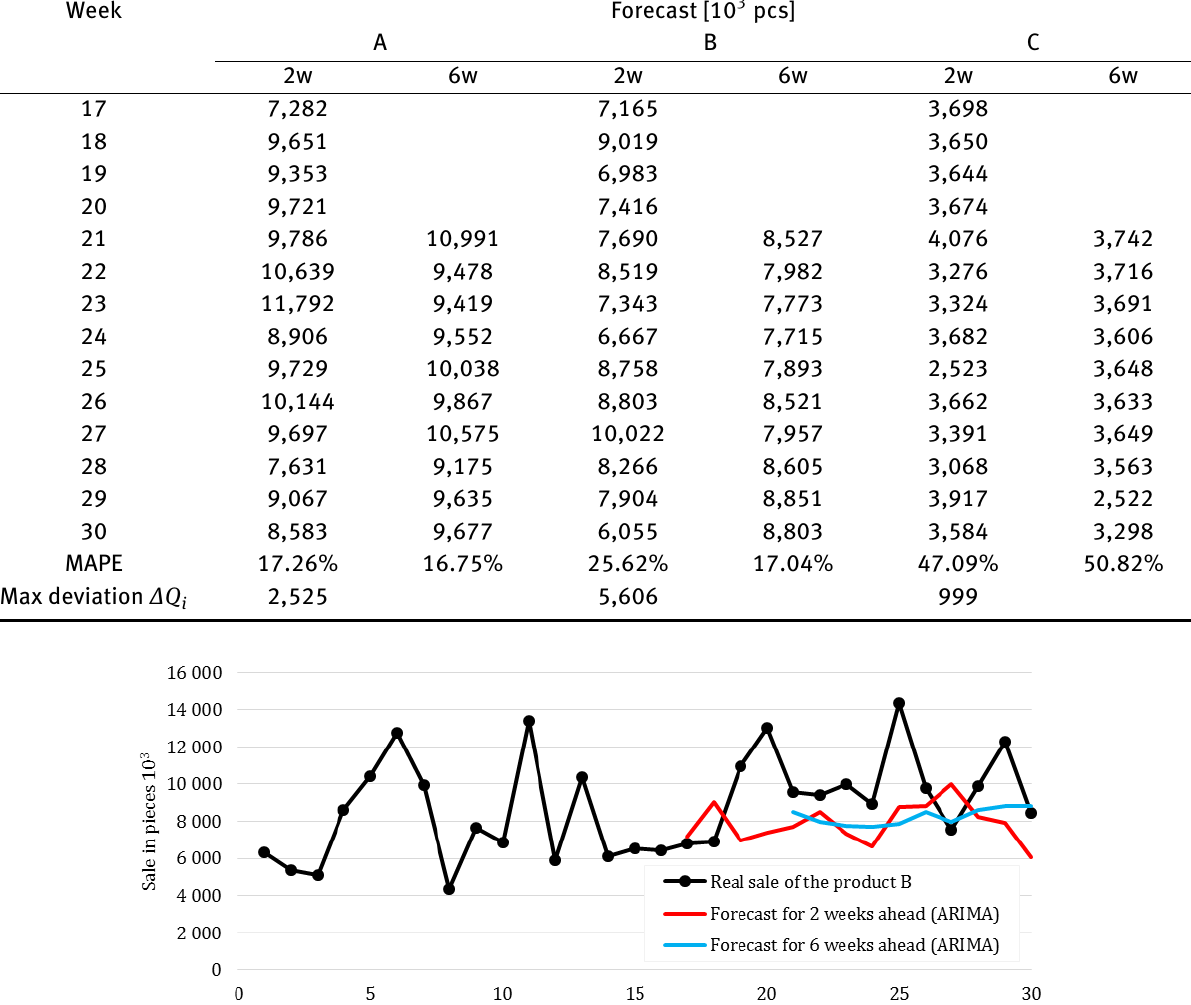
Table 4: Forecast for 2 and 6 weeks.